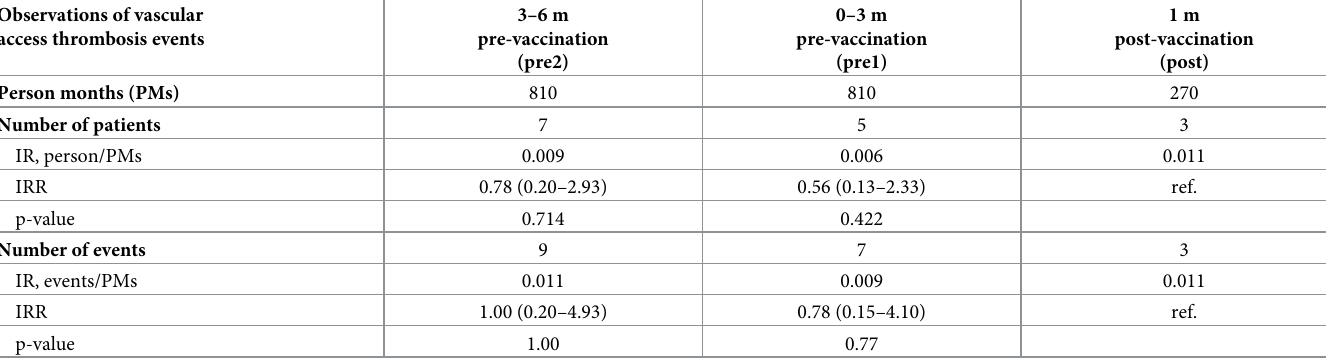
Table 3. Number of patients, events and IRRs for vascular access thrombosis events before and after first dose vaccination with ChAdOx1. Observations of vascular access thrombosis